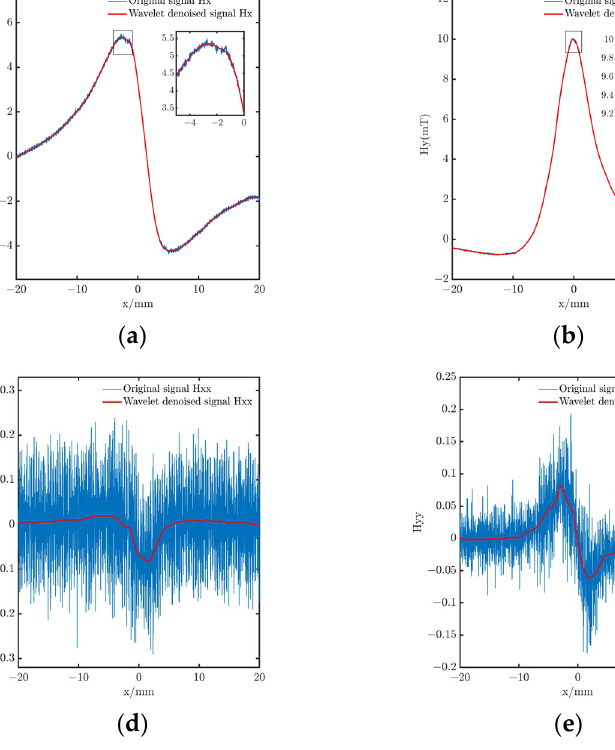
Figure 5. Comparison of wavelet threshold denoising effects. ( a ) Comparison of normal component signals. ( b ) Comparison of tangential component signals. ( c ) Comparison of horizontal component signals. ( d ) Comparison of gradient values of normal component signal. ( e ) Comparison of gradient values of tangential component signal. ( f ) Comparison of gradient values of horizontal component signal.